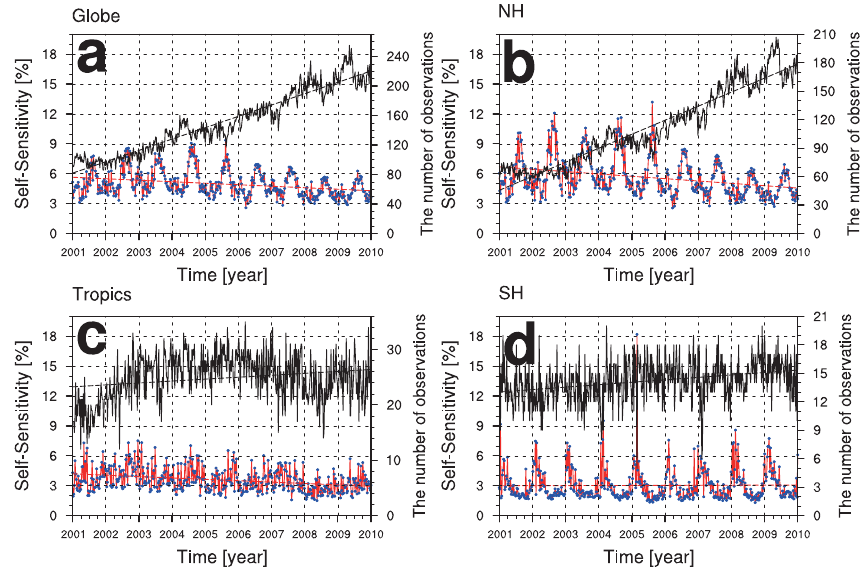
Figure 6. Time series of the average self-sensitivity (red solid line with blue dots) and the number of observations (black solid line) with a weekly temporal resolution (a) around the globe and in the (b) Northern Hemisphere, (c) tropics, and (d) Southern Hemisphere from 2001 to 2009. The dashed lines represent the regression lines for the average self-sensitivity (red dashed line) and the number of observations (black dashed